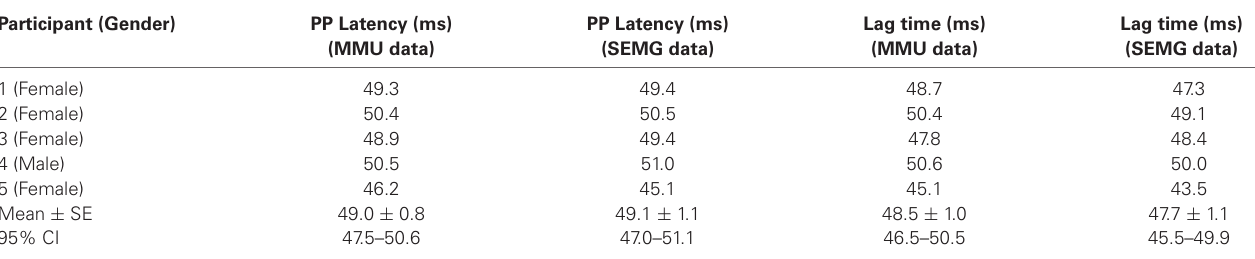
Table 2 | Peak to peak (PP) latency between the force and EMG signals calculated with cumulated average method and the lag time between the force and EMG signals calculated with cumulant density function